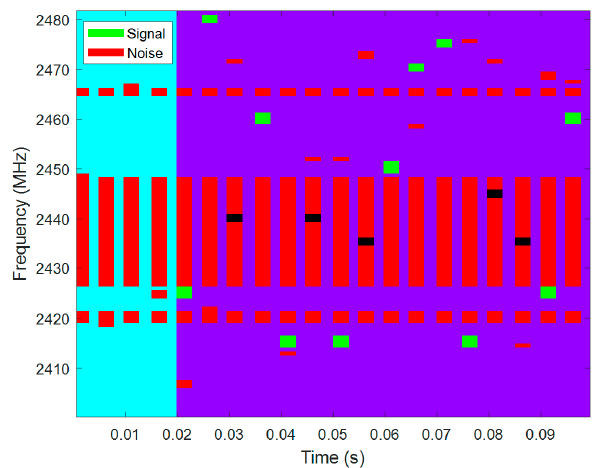
Figure 14. Signal (green) and noise (red) overlapping. There are different sources that contribute to noise: static networks and dynamic networks that hop over different frequencies. The noise is analysed during the observation time (blue) to determine the hopping sequence of the signal of interest. The signal of interest is only transmitted during the operation time (purple). The overlapping of signal and noise is represented in black. This overlap only implies time and frequency coexistence; for an error to occur, the SNR must be higher than the receiving sensitivity of the nodes too.